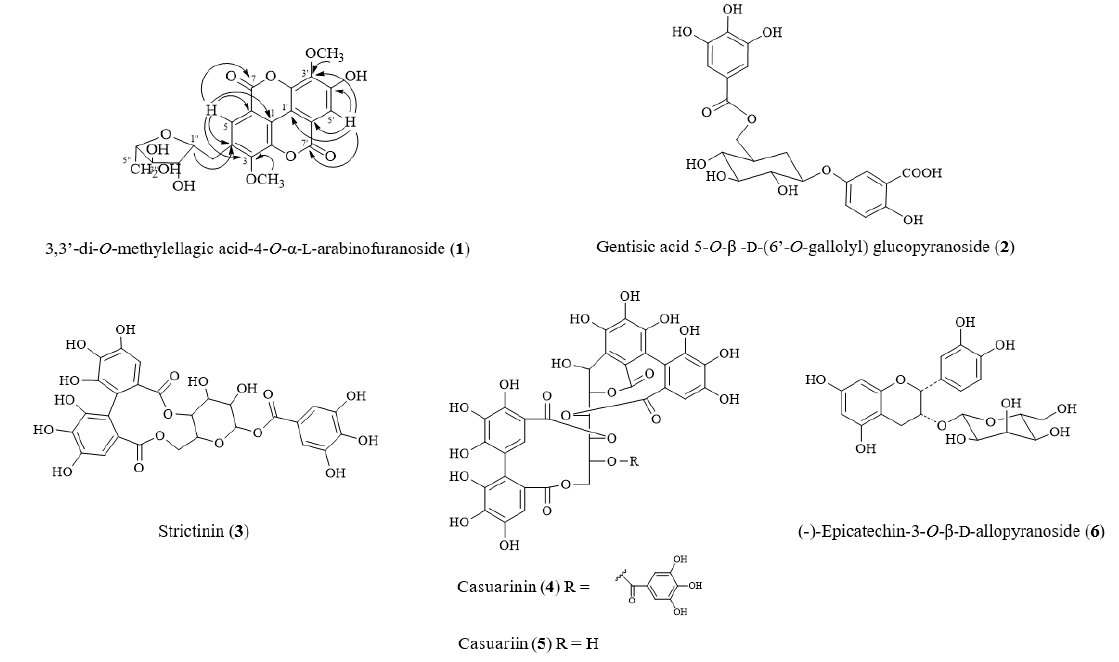
Figure 1. Structure of compounds isolated from T. formosana.